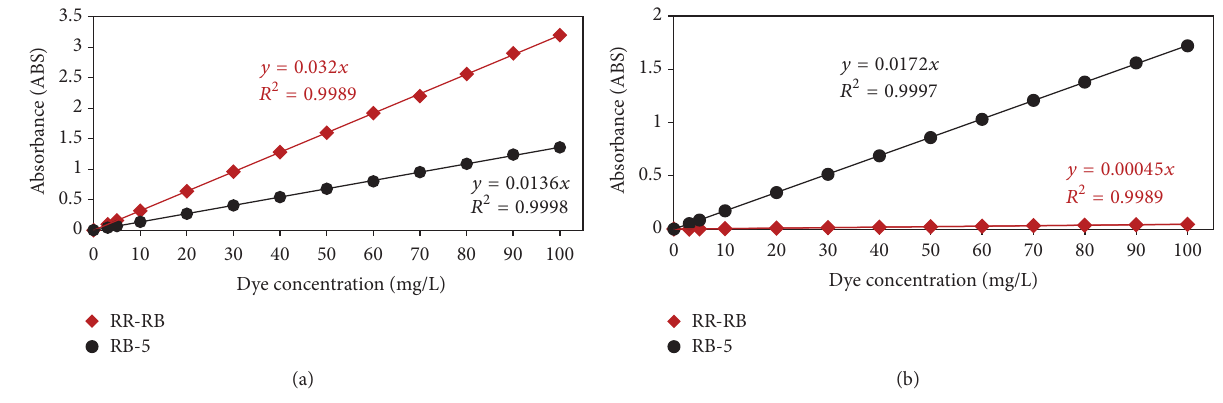
Figure 2: Calibration curves for RR-RB and RB-5 dyes at (a) 𝜆 max = 288 nm and (b) 𝜆 max = 599